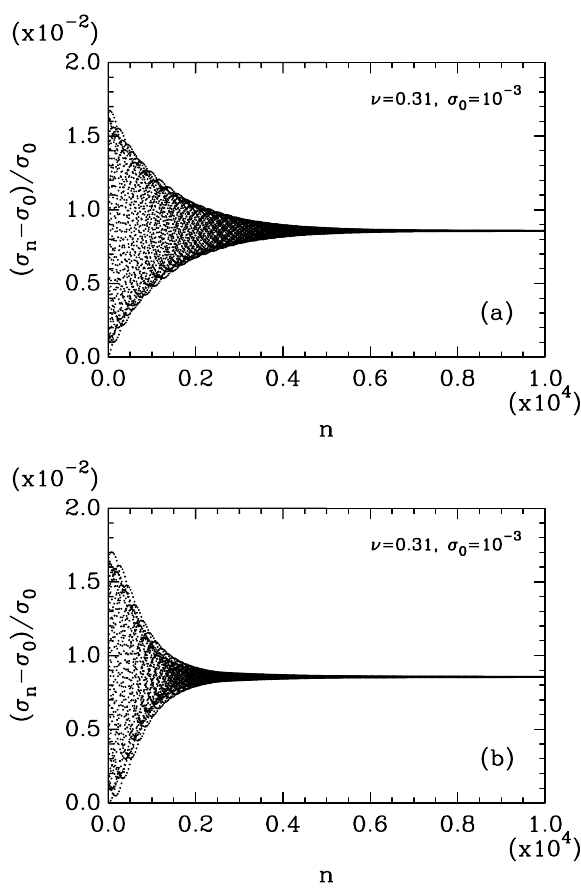
FIG. 3. The same as Fig. 1 but with n (cid:173) (cid:48)(cid:46)(cid:51)(cid:49)